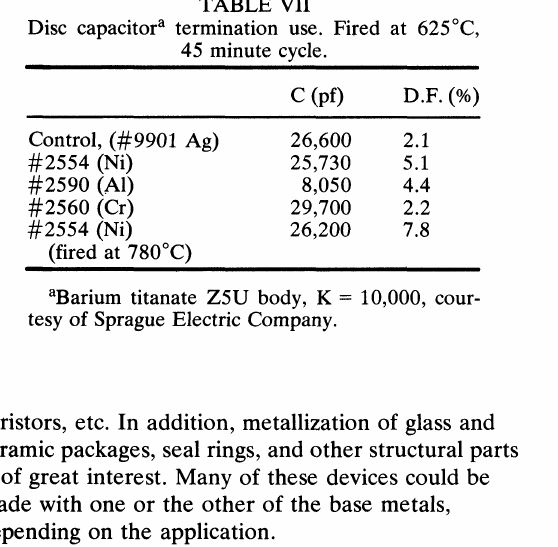
TABLE VII Disc capacitor termination use. Fired at 625C, 45 minute